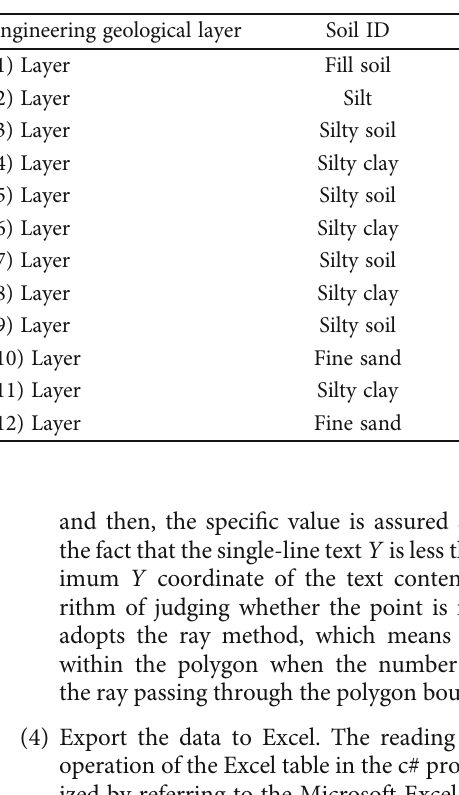
Figure 1: The overall process of borehole histogram information extraction. Table 1: Engineering geological strati fi cation of shallow soil in Kaifeng west